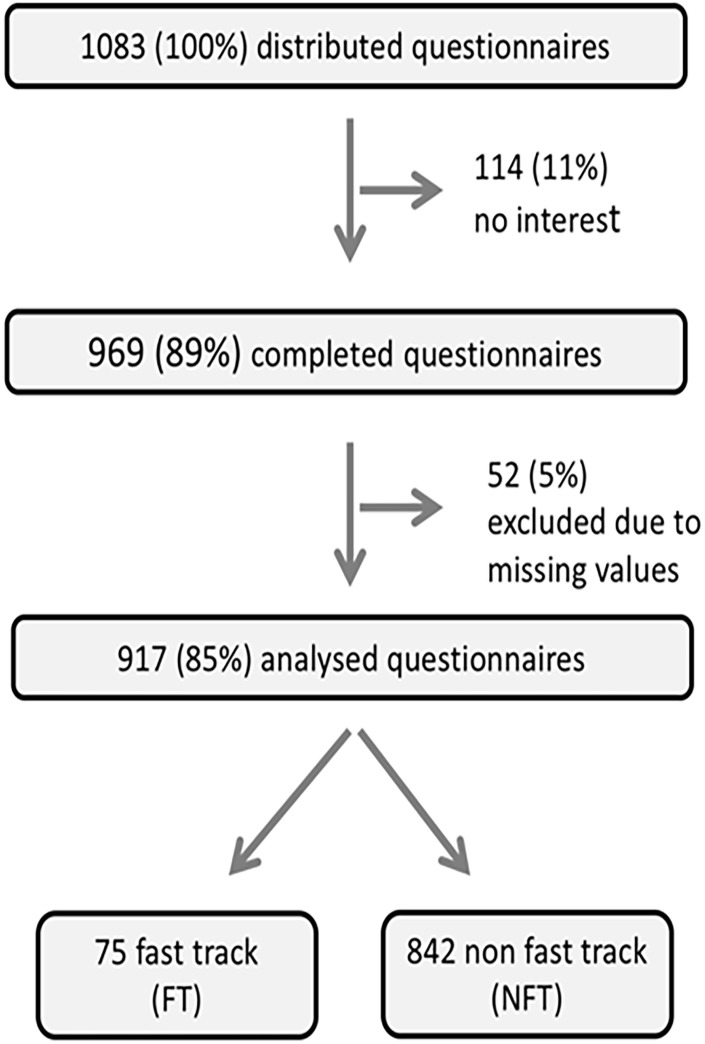
Study participants.